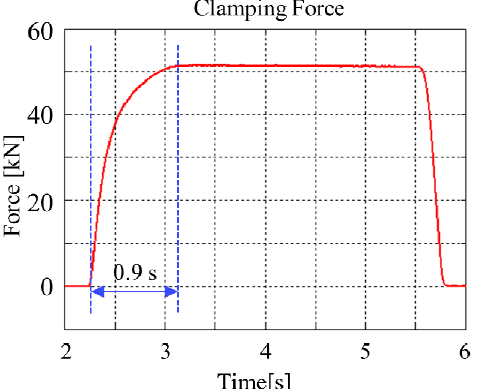
Figure 8. Clamping force experimental results for the pneumatic brake system of the HEMU-430X.